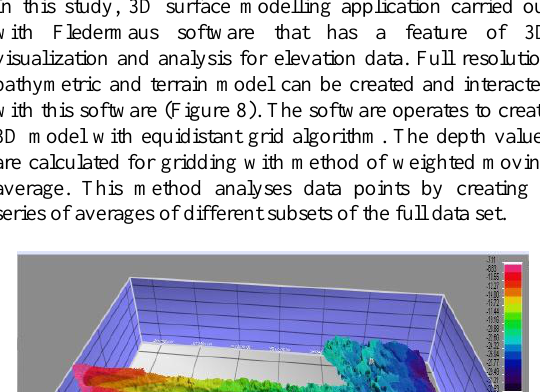
Figure 6: Tracks of survey lines.